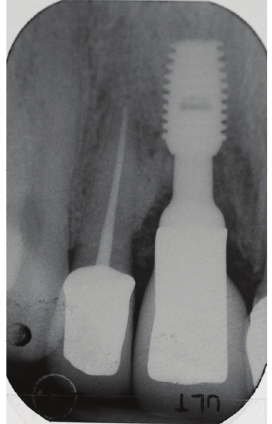
Figure 27: The patient’s natural looking smile at the end of the therapy.